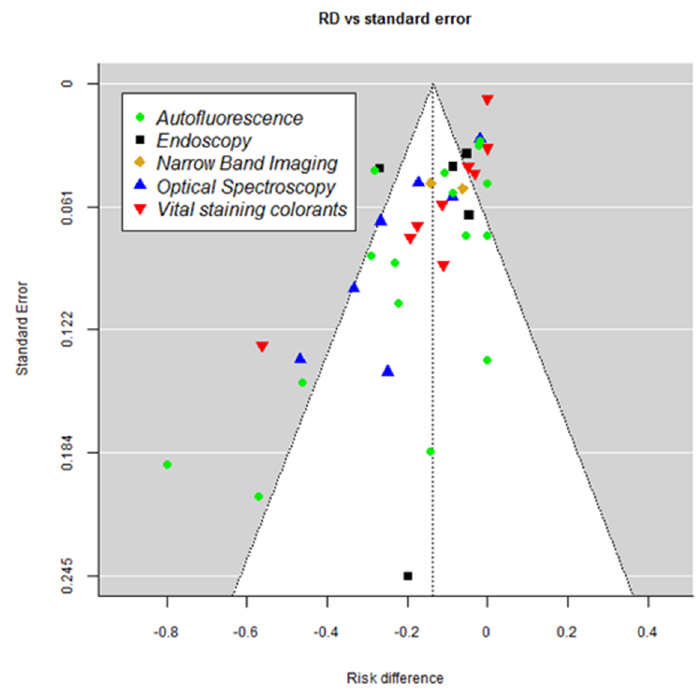
Figure 3. Funnel